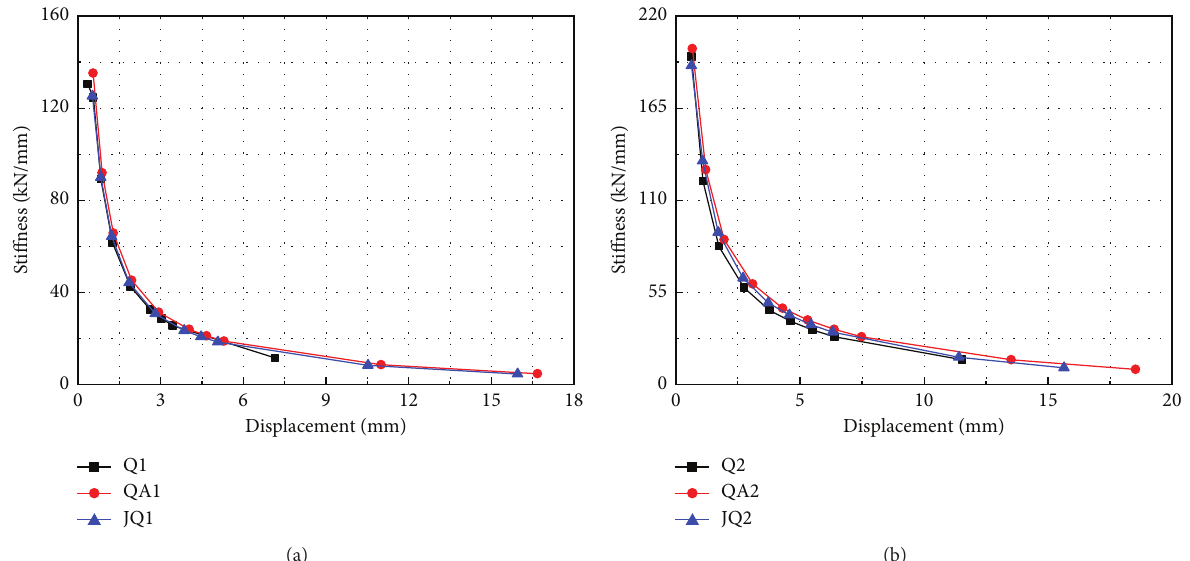
Figure 7: Stiffness degradation curves of specimens. (a) Stiffness degradation curve of wall with aspect ratio of 1.8. (b) Stiffness degradation curve of wall with aspect ratio of 0.5.